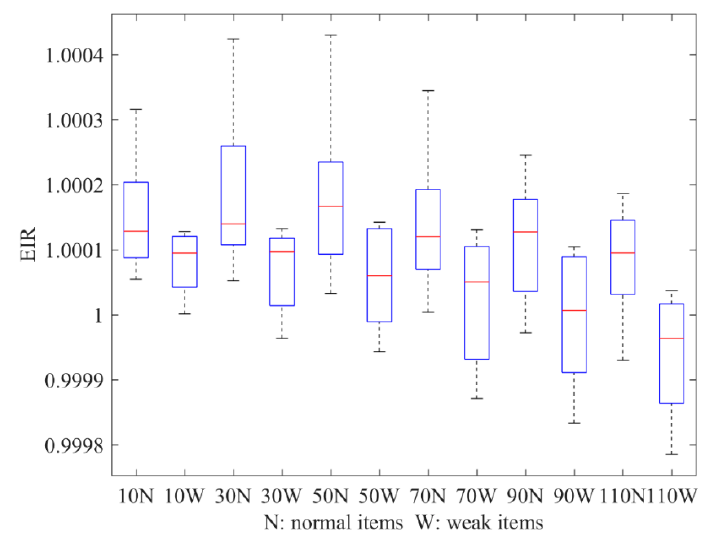
Figure 8. Box plots of the EIR.